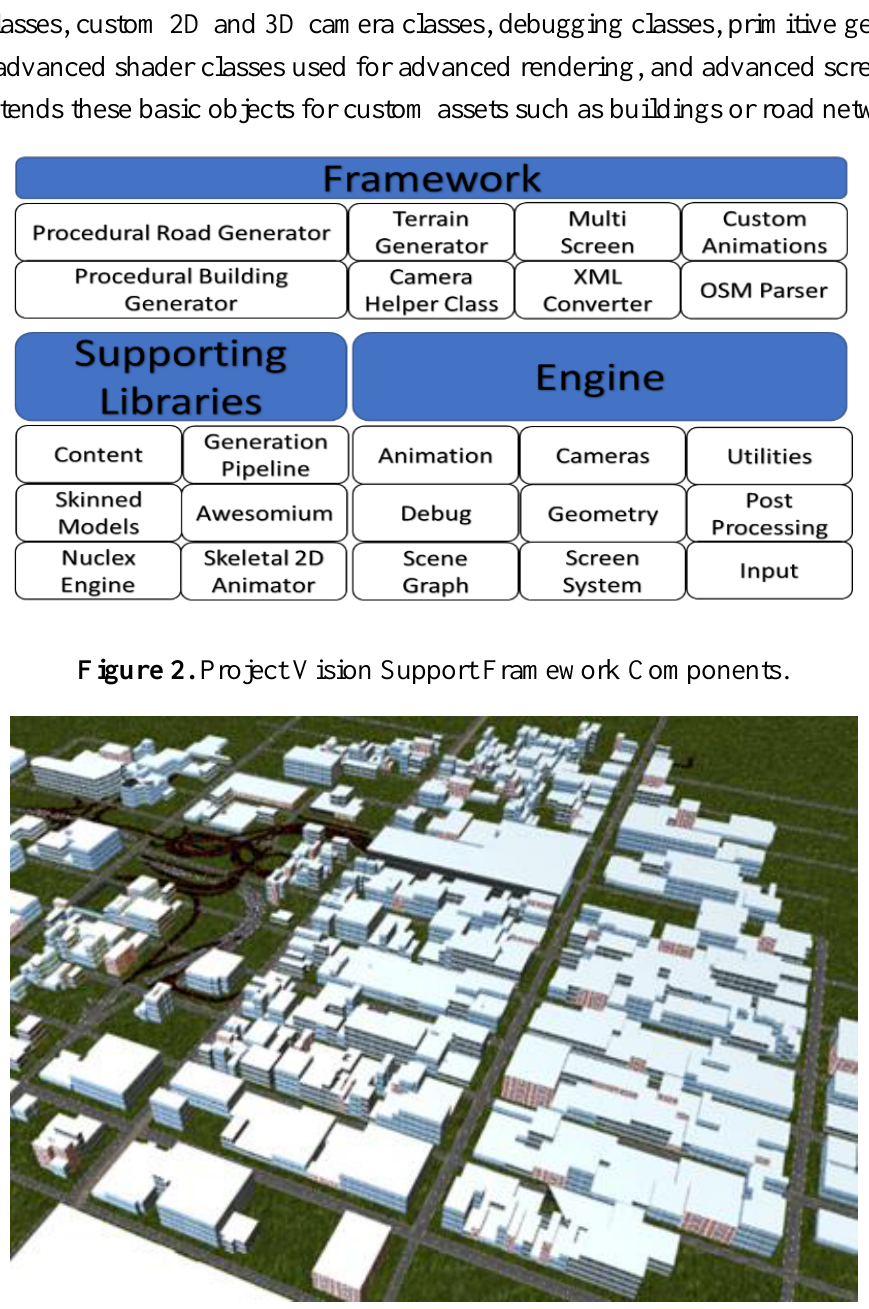
Figure 3. PVS procedural city generation of New York Manhattan containing buildings, roads, and rail